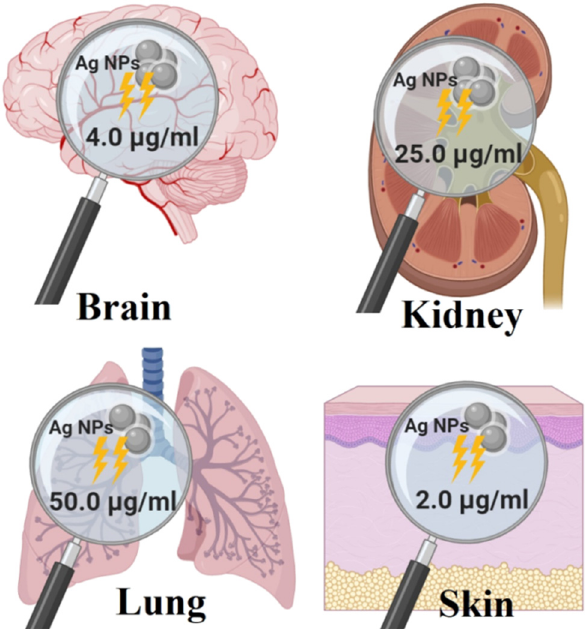
Figure 10: The toxicity levels of AgNPs in di ff erent